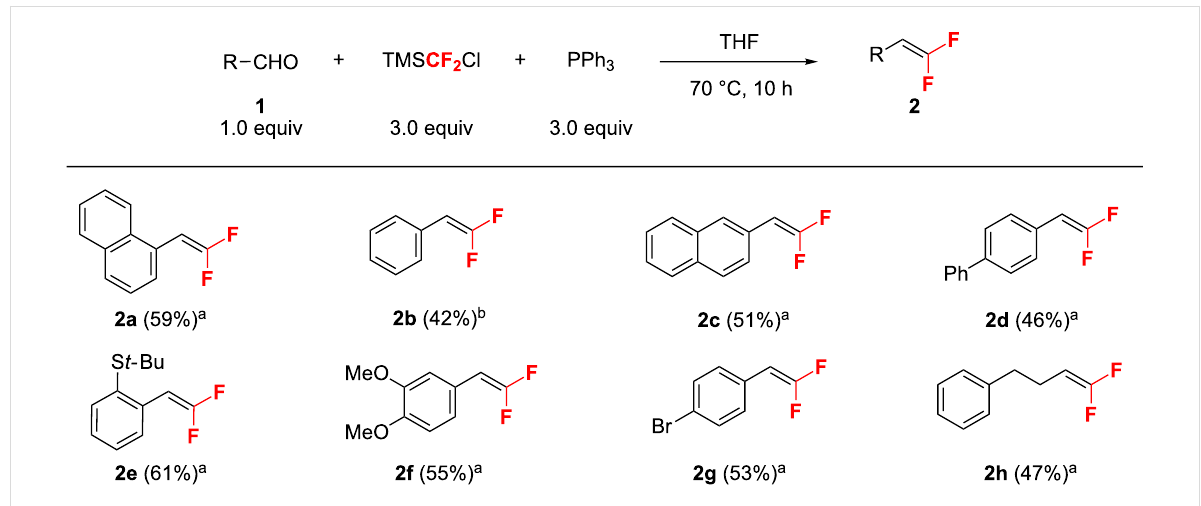
Figure 1: gem -Difluoroolefination of aldehydes. Reactions were performed on 0.5 mmol scale in a pressure tube. a Isolated yield. b Yield was deter- mined by 19 F NMR spectroscopy using PhCF 3 as an internal standard.